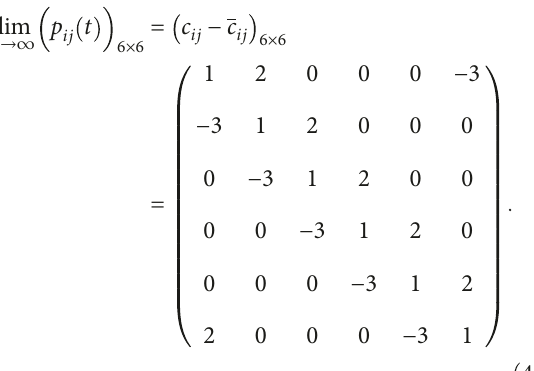
Figure 4: Parameter identi fi cation of the system (4) – (7): lim t = β